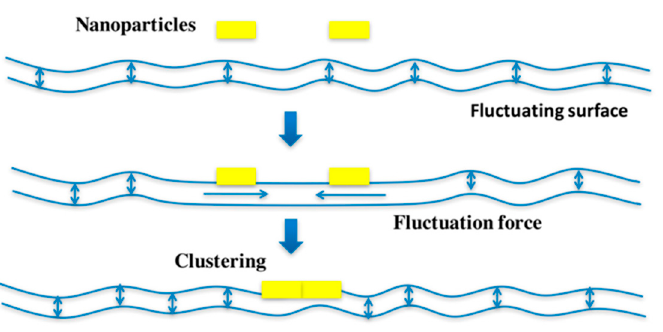
Figure 3. Hypothesis on fluctuation force-driven clustering. Thermally excited fluctuations are suppressed by membrane inclusions (yellow) of nanometric size like STxB, not only at the sites of binding to the membrane, but also for the membrane patch between the two nanoparticles, if they are separated only by a distance of their own size. This perturbation results in an attractive force whose strength is expected to be similar to that of shielded electrostatics or van der Waals interactions. Reproduced with permission from Toxins, Ref. [24] .